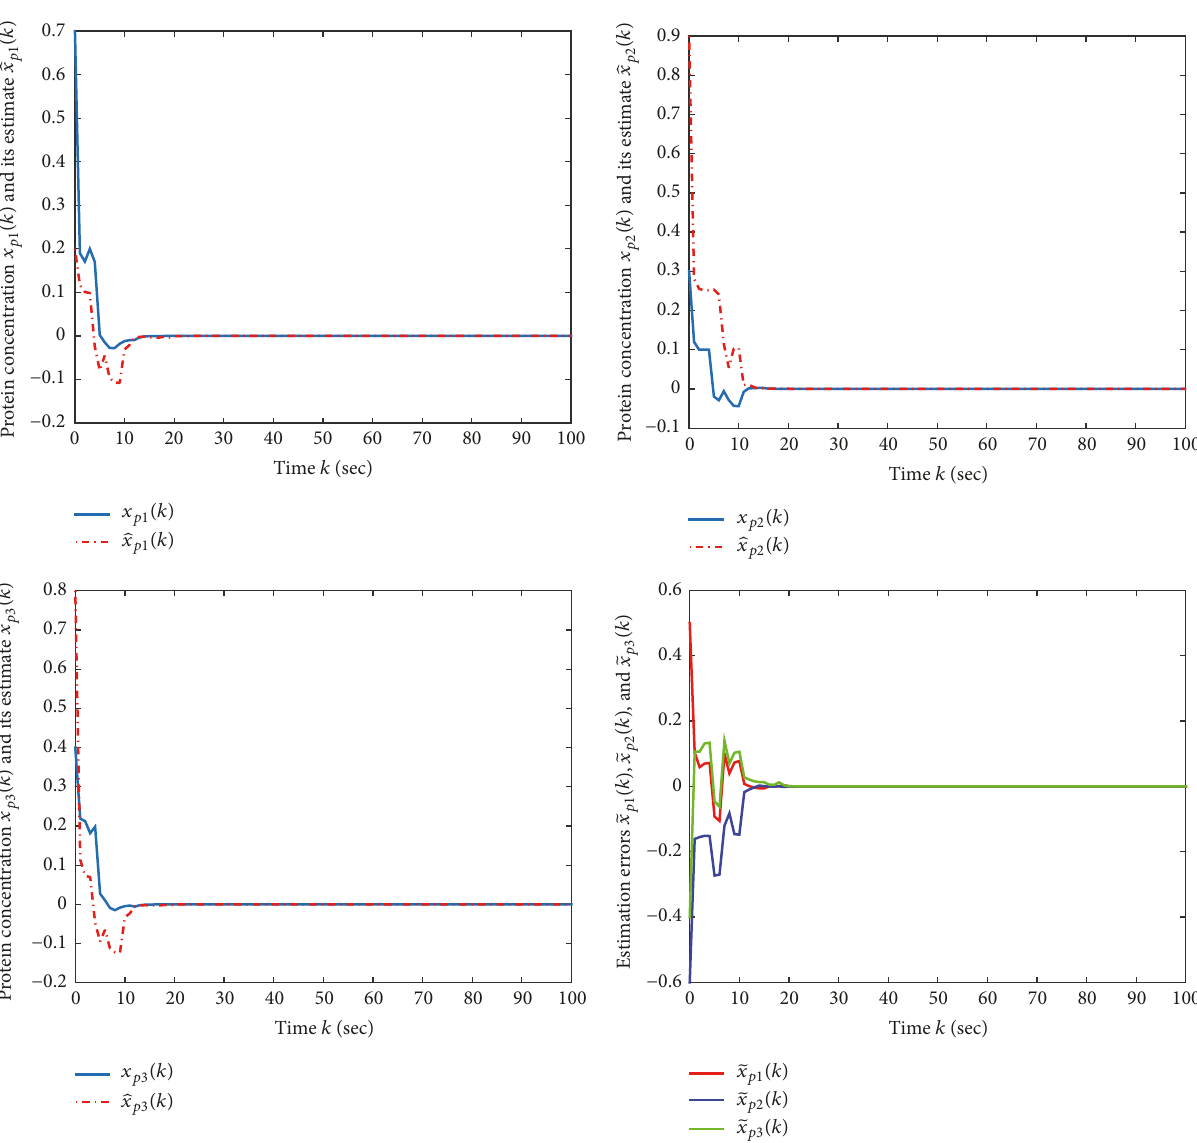
Figure 4: Protein concentrations, its estimates, and the estimation error of Example